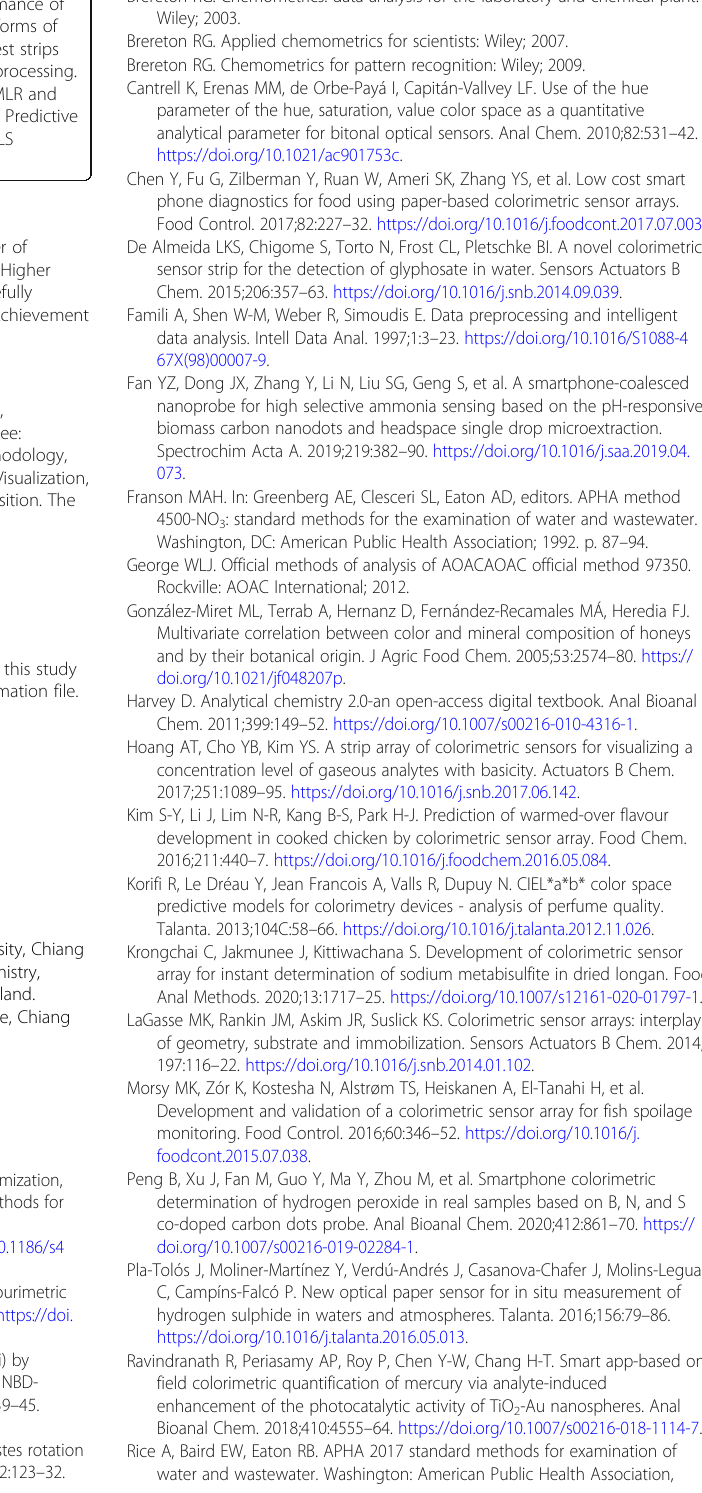
Table S4 . Predictive performance of Cu 2+ test strips using ULR, MLR and PLS coupled with various forms of data-reprocessing. Table S5 . Predictive performance of NO 3- test strips using ULR, MLR and PLS coupled with various forms of data-reprocessing. Table S6 . Predictive performance of PO 43- test strips using ULR, MLR and PLS coupled with various forms of